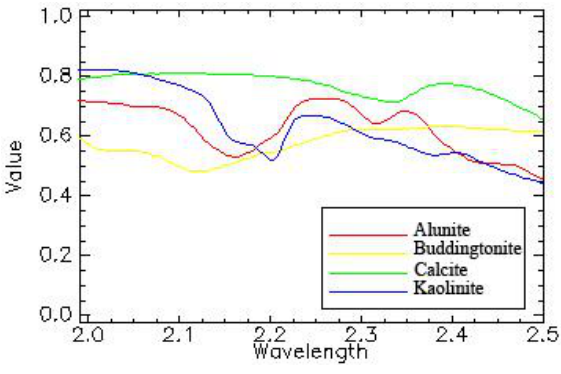
Figure 1. Extracted endmember Comparison using PPI and SMACC methods by library and field spectral.